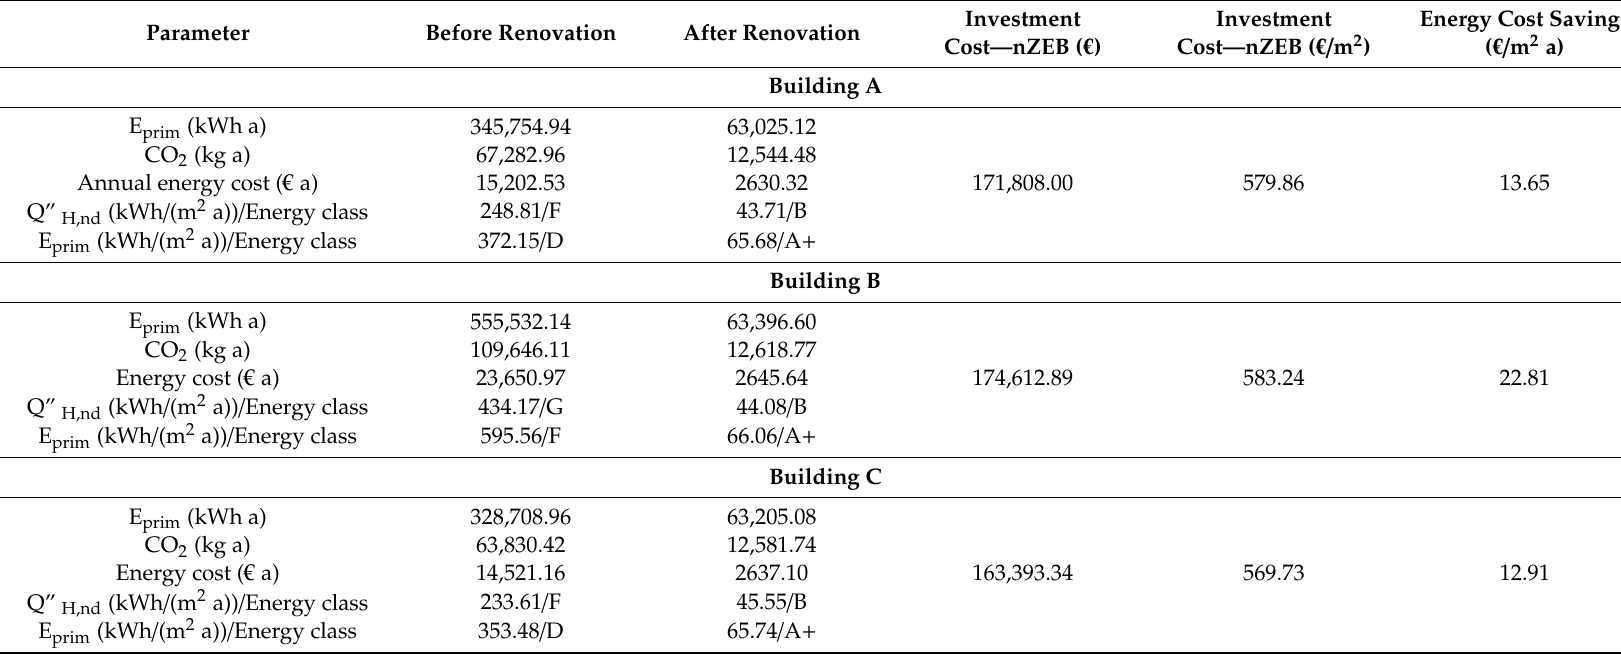
Table 4. Annual energy consumption, annual energy cost, and initial investment cost for renovation into nearly zero-energy buildings